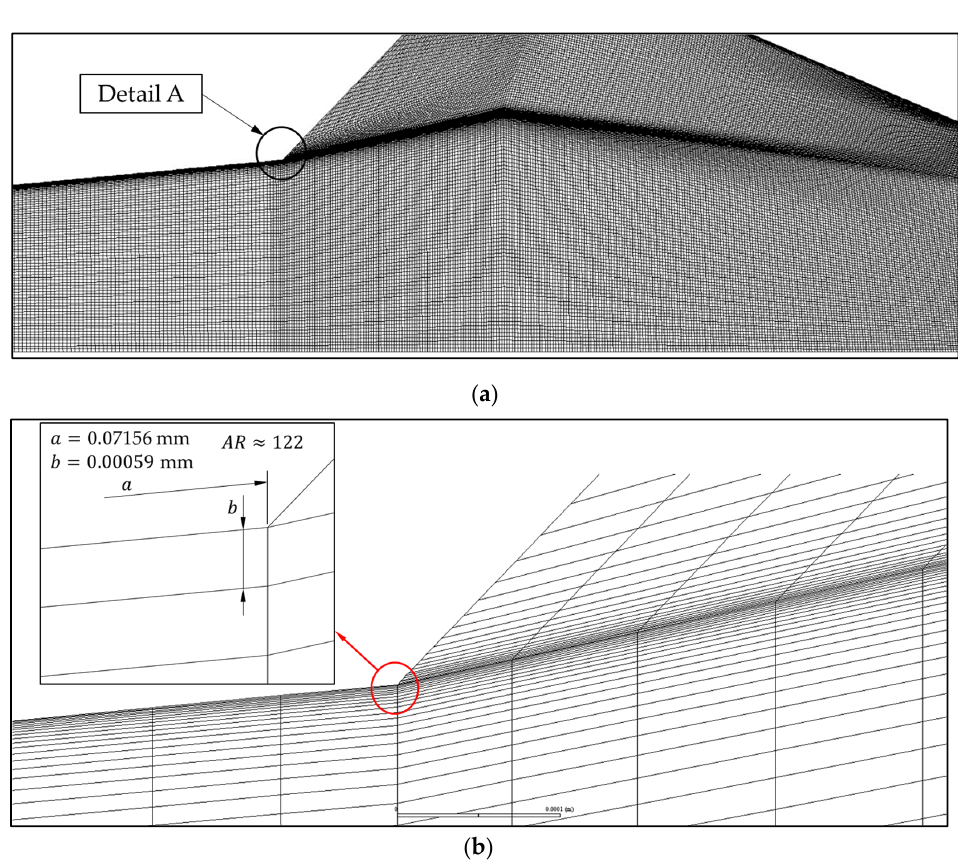
Figure 7. The sample of the chosen mesh (medium mesh) around the exit of the primary nozzle as well as the inlet of the secondary flow is shown in ( a ) and the “Detail A” is shown in ( b ).